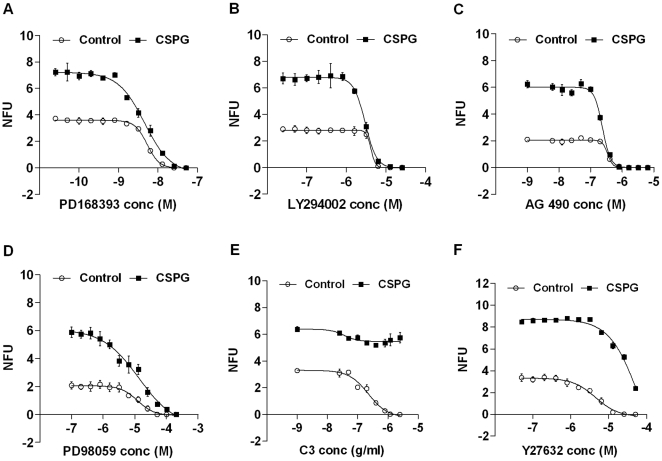
Effect of inhibitors of EGFR and RhoA signaling pathways on NFUs.Cells were grown at 2×103 cells/ml, inhibitors added at the indicated concentrations and nsph formation followed for five days in the presence or absence of CSPG (50 µg/ml). (A) EGFR kinase inhibitor PD168393 concentration range (50 pM–50 nM). (B) PI3K inhibitor LY294002 concentration range (25 nM–25 µM). (C) JAK inhibitor AG490 concentration range (6.25 nM–6.4 µM). (D) ERK inhibitor PD98059 concentration range (100 nM–200 µM). (E) RhoA inhibitor C3 concentration range (25 ng/ml–25 µg/ml). (F) Rho kinase inhibitor Y27632 concentration range (50 nM–50 µM). Data are presented as mean ± SEM, n = 3 from 1 representative experiment. Similar results were obtained in two other experiments.